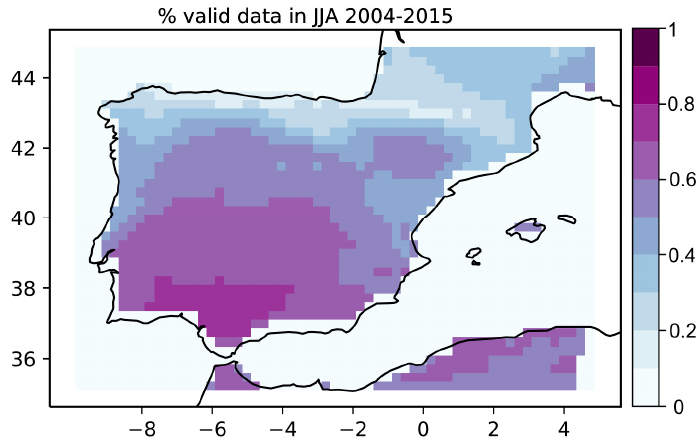
Figure 1. Percentage of valid data during summer (June–August) between 2004 and 2015.